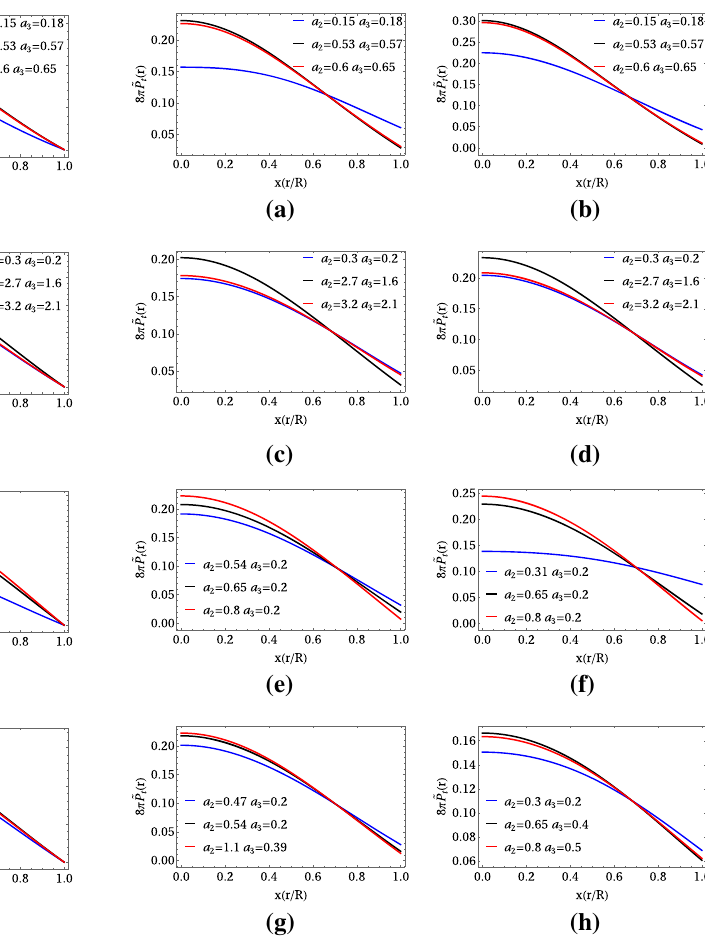
Fig. 5 ˜ P t ( r ) as a function of r for Model 1: ( a ) u = 0.19803, ( b ) u = 0.2035, Model 2: ( c ) u = 0.19803, ( d ) u = 0.2035, Model 3: ( e ) u = 0.19803, ( f ) u = 0.2035, Model 4: ( g ) u = 0.19803, ( h ) u =